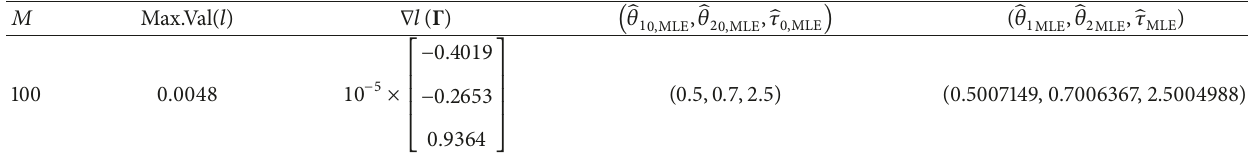
Table 5: Table showing value of Max.Val (𝑙) , ∇𝑙( Γ ) , and